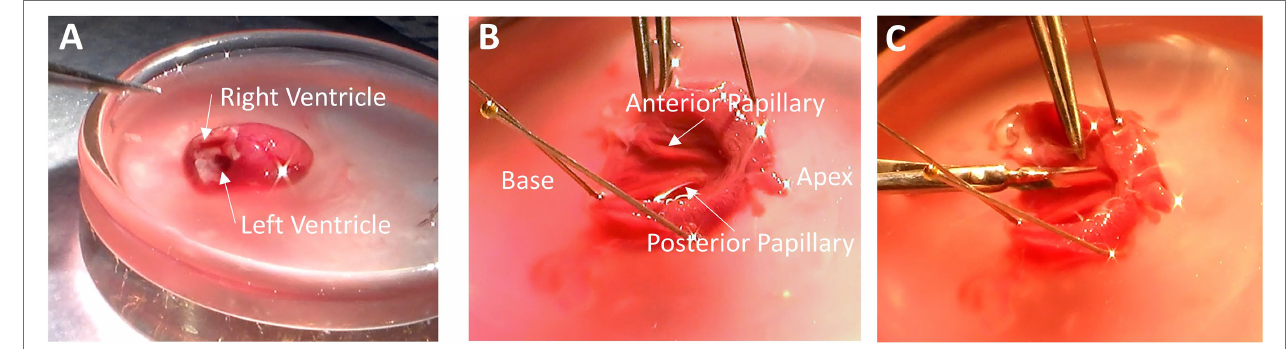
FIGURE 1 | Removing Papillary Muscles. (A) With the atria trimmed away, the base of the heart is exposed, and the ventricles can be easily identified. The right ventricular cavity is crescent-shaped, and its free wall is thin. The left ventricular cavity is more circular in shape, and the walls are thick. (B) After removing the right ventricle and cutting down the septum, the endocardium is exposed with the anterior and posterior papillary muscles visible. (C) Remove the papillary muscles by cutting gently along the length of the muscle while being sure not to pull on muscle with the